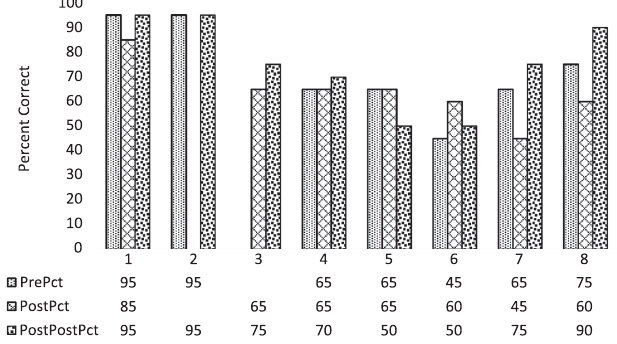
FIG. 4. Three snapshots (pre, post, and post-post) of LPCI percent correct by 6th grade teacher (teachers numbered 1 –